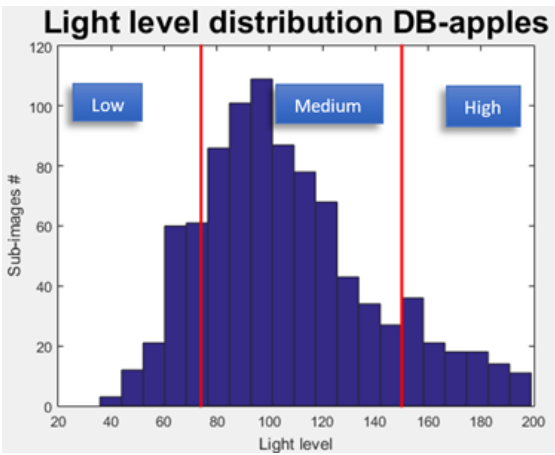
Figure 10. Sub-images level of light